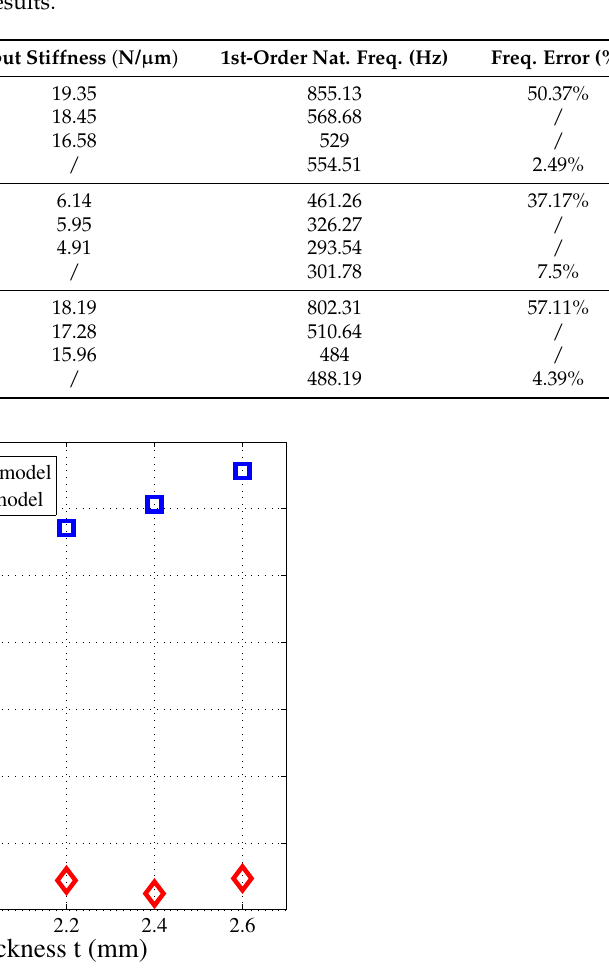
Figure 8. Comparison of natural frequency calculation